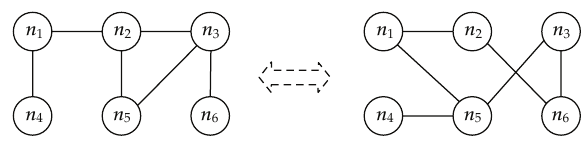
Figure 2: Network topology